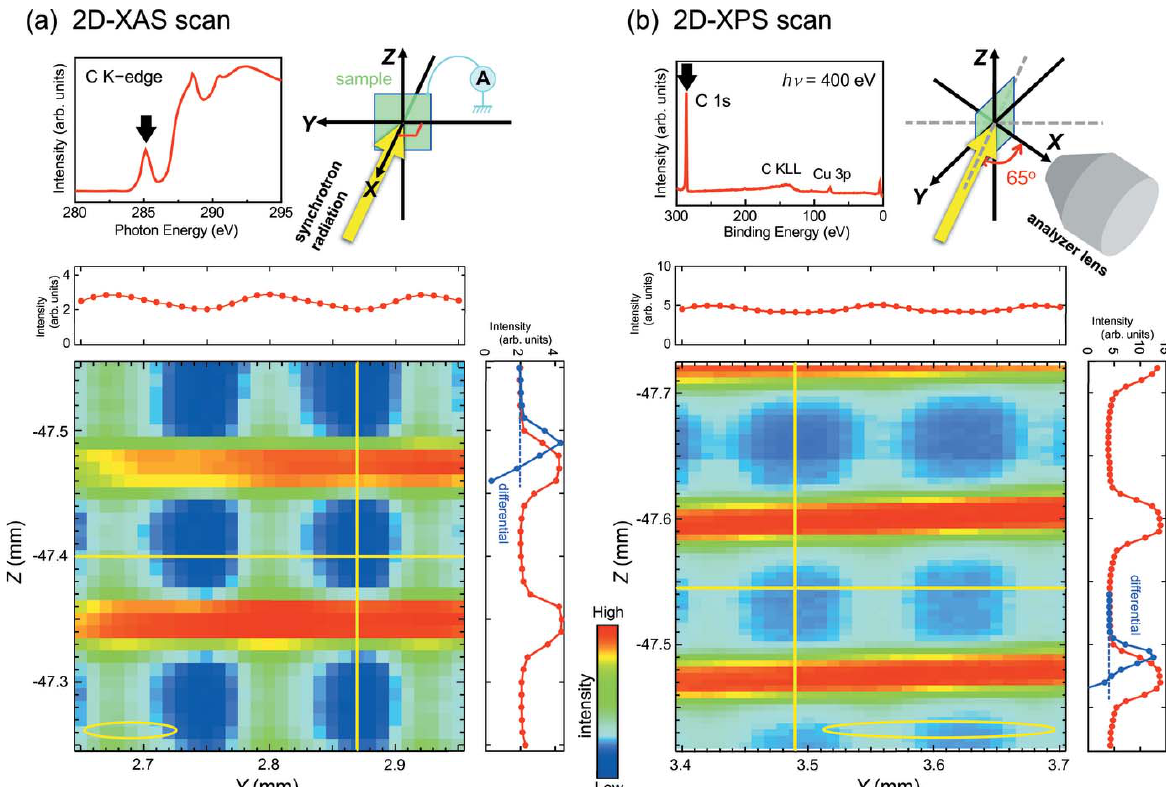
Figure 8 ( a ) 2D-XAS and ( b ) 2D-XPS intensity maps of a copper grid (200 mesh). The absorption intensity at the C K -edge ( h (cid:2) = 285.2 eV) and the photoemission intensity of the C 1 s peak acquired at h (cid:2) = 400 eV (indicated by arrows in the upper left panels showing the XAS and XPS spectra) were monitored to visualize grid images. The 1000 lines mm (cid:2) 1 VLSG and the exit-slit width of 30 m m were used. The incidence angles of the light were 0 (cid:4) (normal incidence) for the XAS scan and 65 (cid:4) for the XPS scans, as schematically drawn at the upper right parts. In the Y -axis scan, the measurements were made with a 10 m m step for both XAS and XPS. Along the Z axis, the measurement intervals were set to be 10 and 5 m m for the XAS and XPS scans, respectively. Ellipses drawn at the bottom of the 2D images represent the estimated sizes of the light irradiation areas: 73 m m (H) (cid:3) 12 m m (V) for 2D- XAS and 184 m m (H) (cid:3) 13 m m (V) for 2D-XPS. Intensity modulations along yellow horizontal and vertical lines are shown at the top and right side of each 2D image, respectively. A part of the differential curve of the intensity curve along the Z axis is shown by a blue line in each right-side